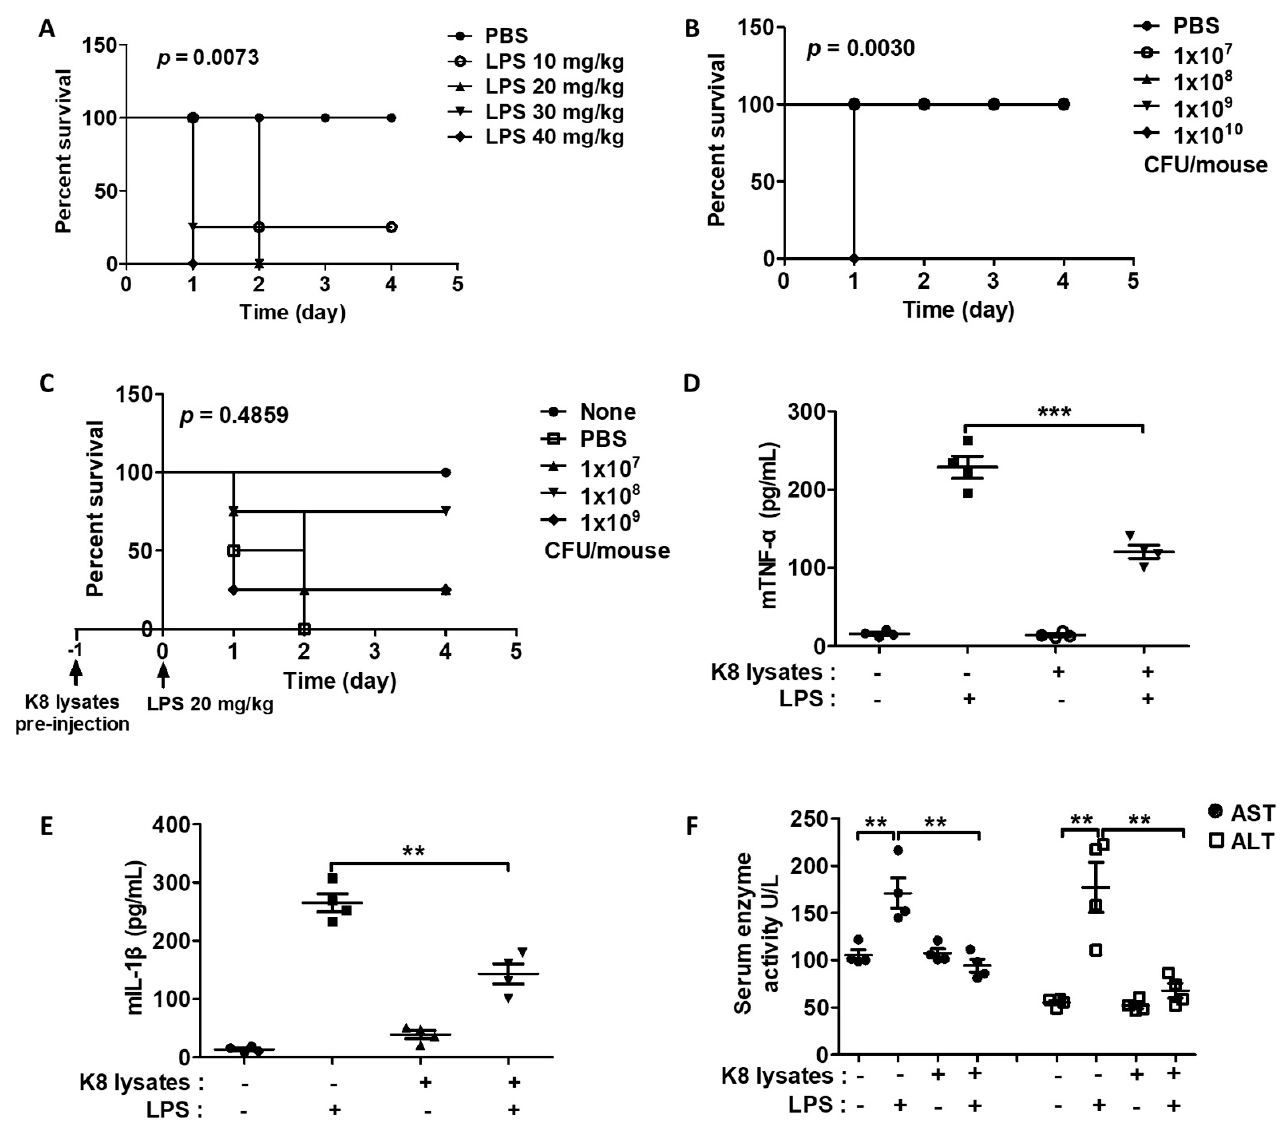
Figure 6. Co-treatment of L. plantarum K8 lysates and LPS decreased the mortality of endotoxin shock mice ( A ) BALB/C mice (seven-weeks-old, n = 4) were intraperitoneal (IP) injected with LPS from 10 mg/kg to 40 mg/kg. ( B ) Mice (n = 4) were IP injected with L. plantarum K8 lysates at the indicated concentrations. ( C ) Mice (n = 4) were IP pre-injected with PBS or indicated concentrations of L. plantarum K8 lysates; after 24 h, mice were IP injected with 20 mg/kg of LPS. In all experiments, the survival rate was monitored every 12 h. p values were derived by the log-rank (Mantel–Cox) test using GraphPad Prism 5 software ( A – C ). Mouse serum was collected 8 h after IP injection of 20 mg/kg LPS at 24 h after IP injection of PBS or 1 × 10 8 CFU/mouse of L. plantarum K8 lysates. The TNF- α ( D ) and IL-1 β ( E ) levels in serum were determined by ELISA. ( F ) The effect of L. plantarum K8 lysates on serum aspartate aminotransferase (AST) and alanine aminotransferase (ALT) was observed. Statistical analyses were conducted with an unpaired two-tailed t -test ( D – F ). ** p < 0.01; *** p <